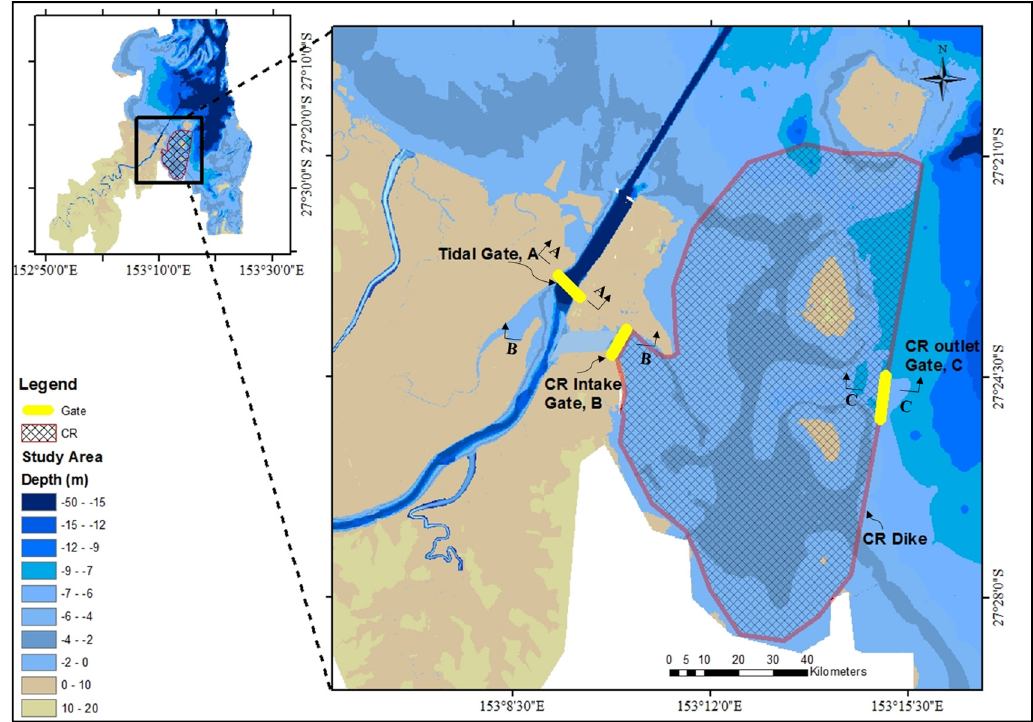
Figure 3. CR dike with intake, tidal, and outlet gate.